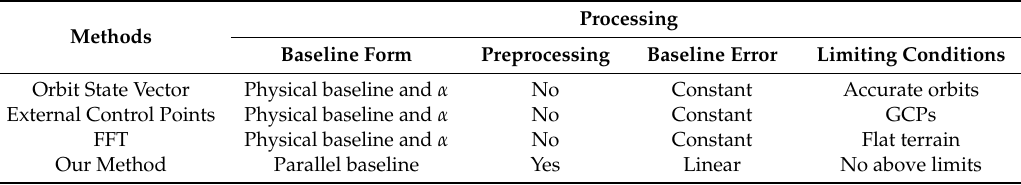
Table 1. Methods comparison.